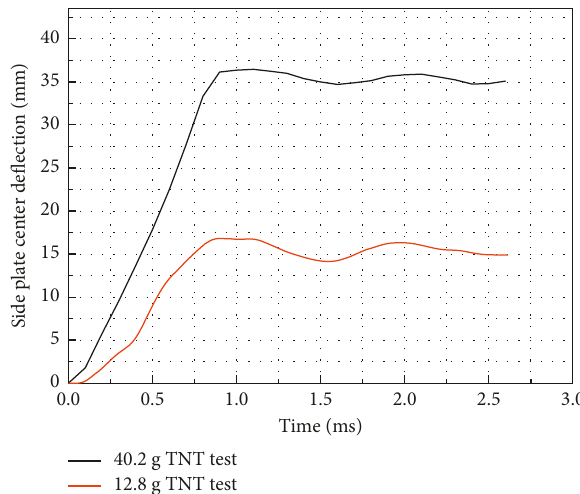
Figure 4: The side plate center deflection-time curves obtained through numerical